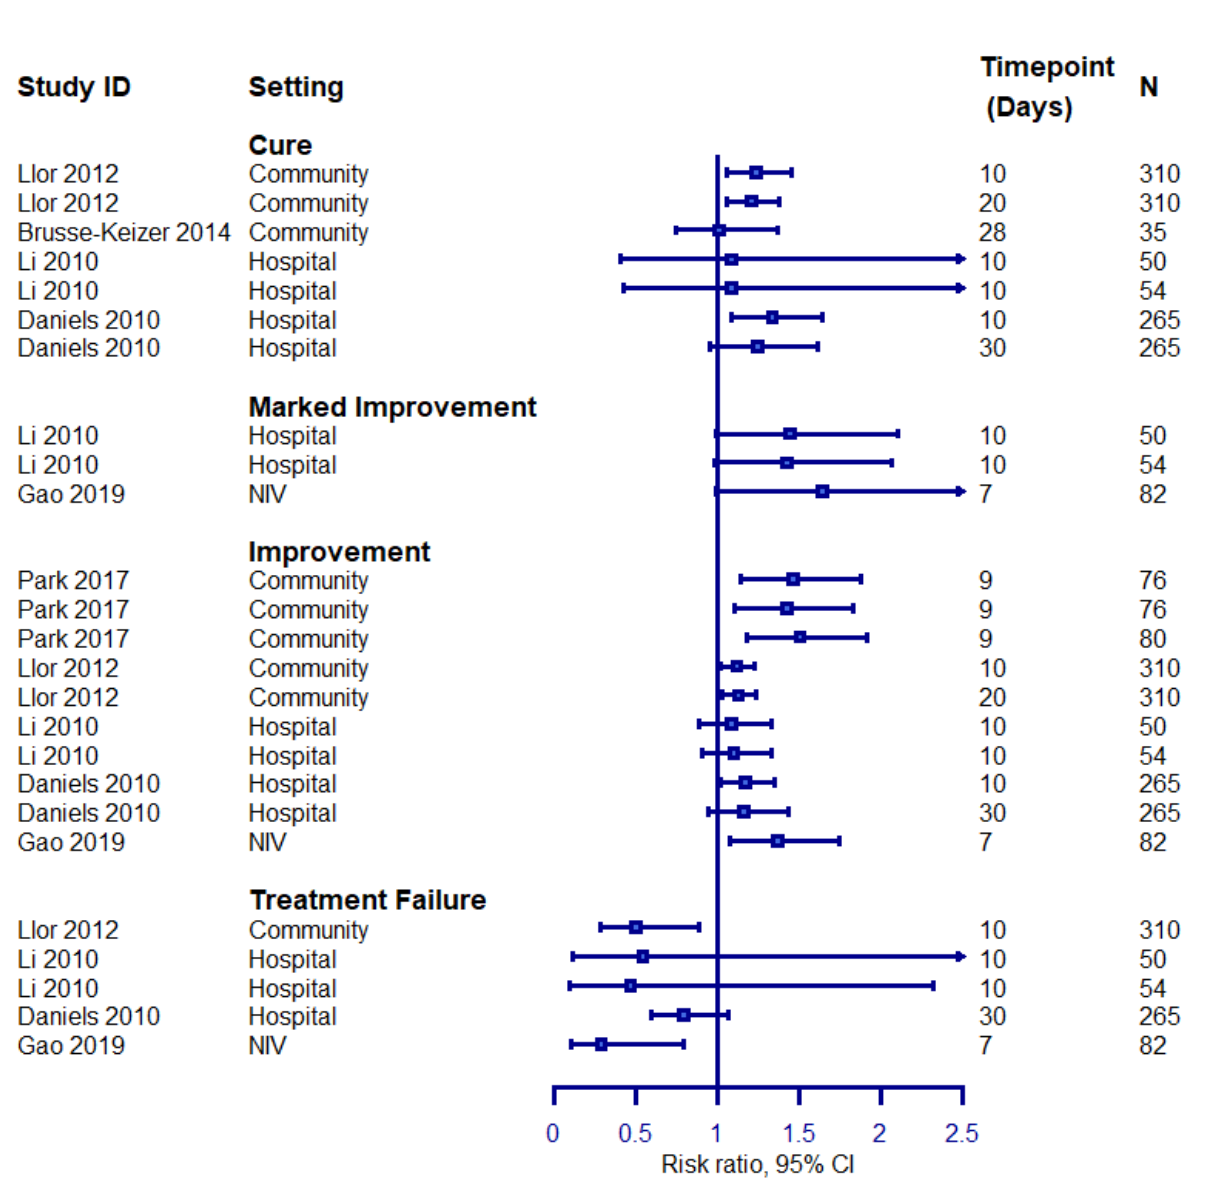
Figure 4. Treatment effects on treatment failure rates in superiority trials assessing cure, marked improvement, improvement, or treatment failure defined using descriptive instruments. The left-hand side favours the intervention. N: study population.